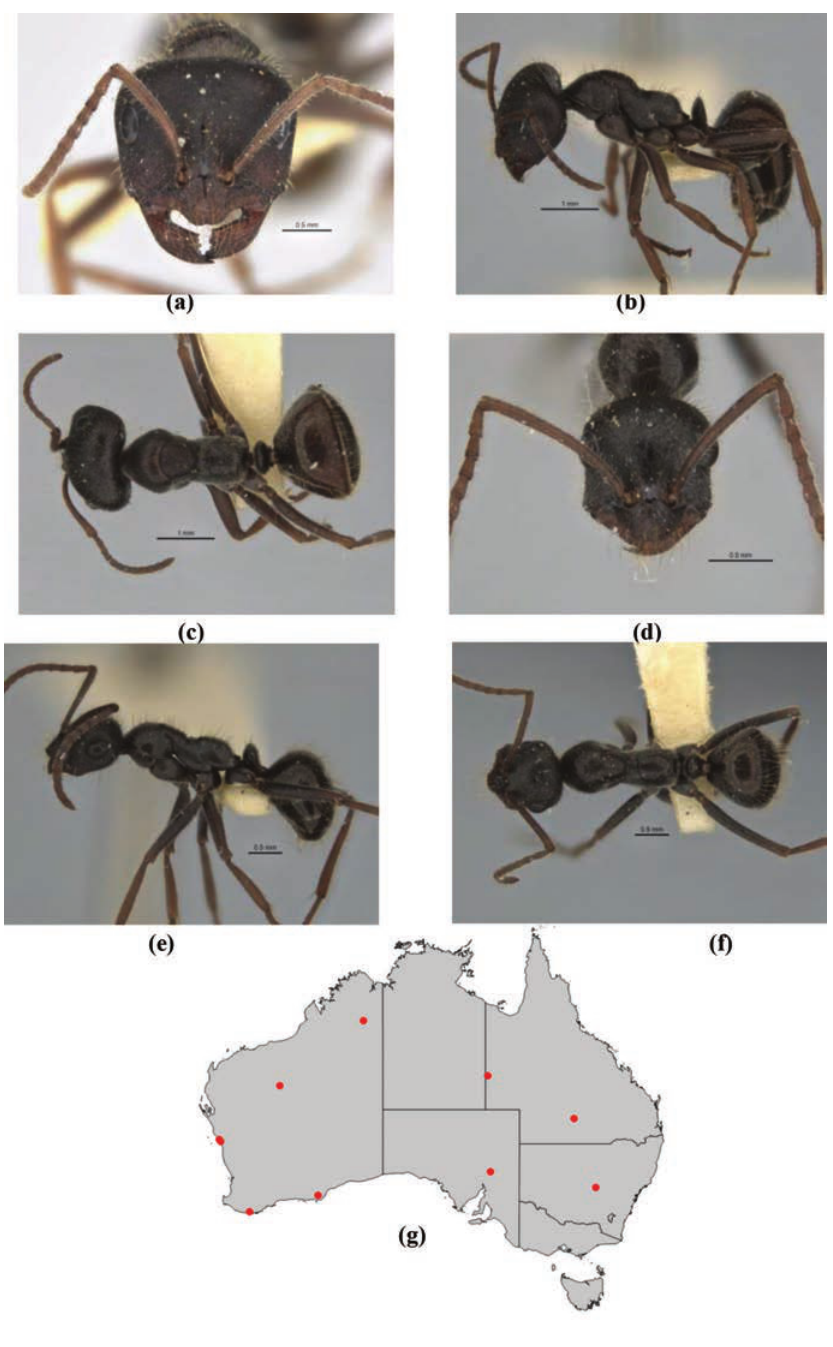
Figure 8. Melophorus canus sp. n.: major worker paratype (ANIC32-900003–third ant from top) frons ( a ), profile ( b ) and dorsum ( c ); minor worker (ANIC32-900003–top ant) holotype frons ( d ), profile ( e ) and dorsum ( f ); distribution map for the species ( g ). Low resolution scale bars: 1 mm ( b, c ); 0.5 mm ( a, d–f